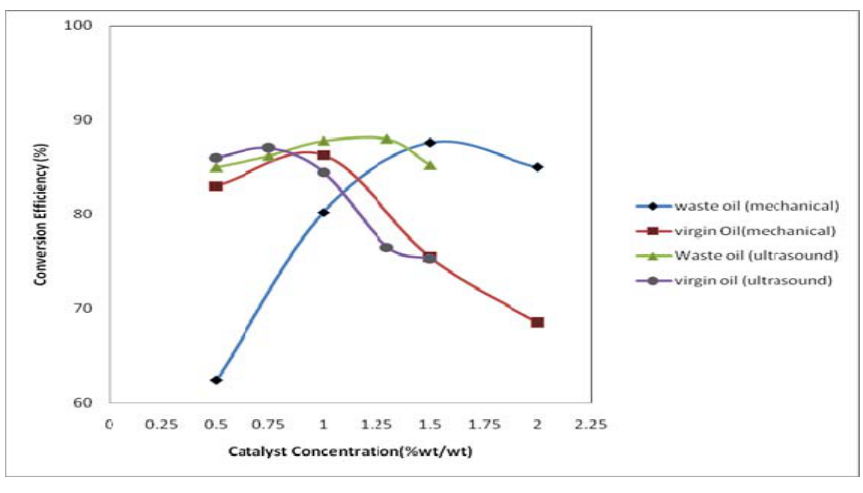
Figure 2. Effect of catalyst concentration on conversion efficiency of the oil samples under a 6:1 methanol/oil ratio at 30 °C and reaction time of 30